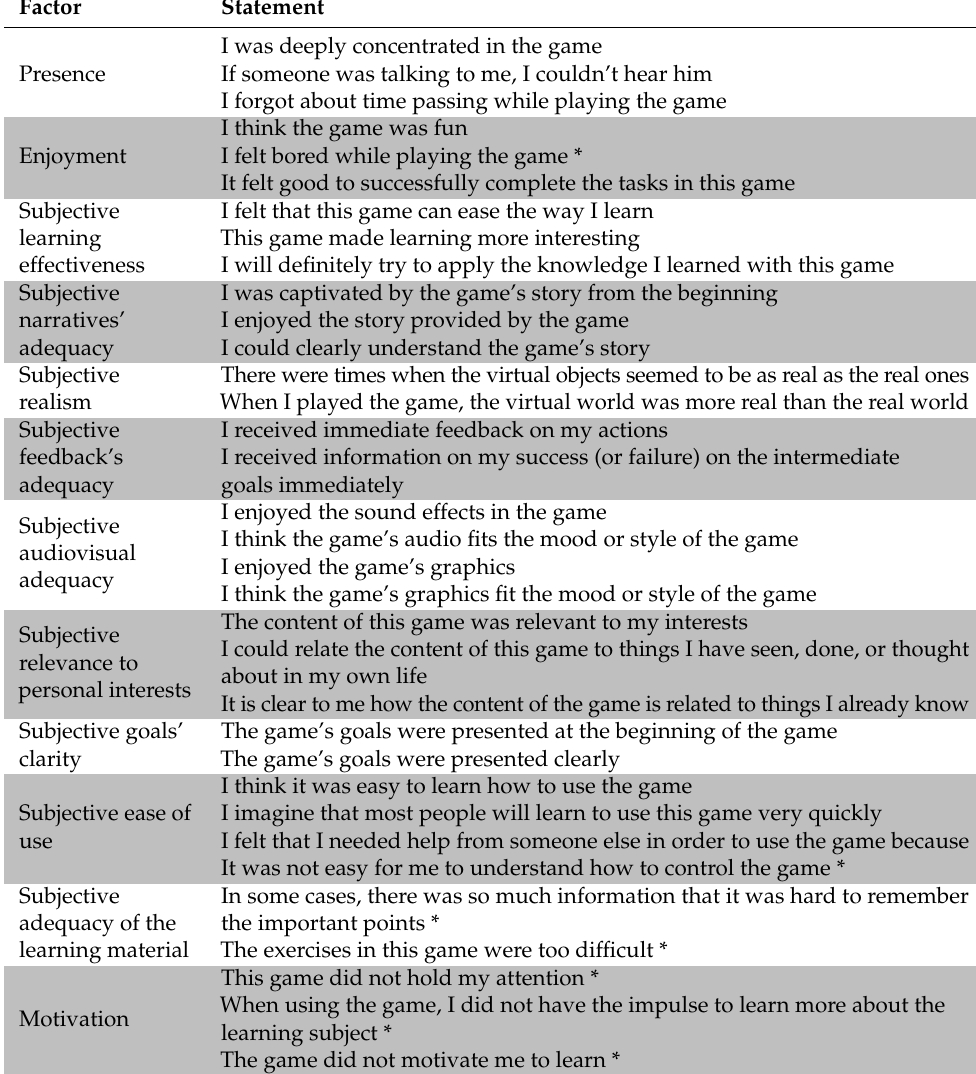
Table A1. Serious Game Evaluation Scale